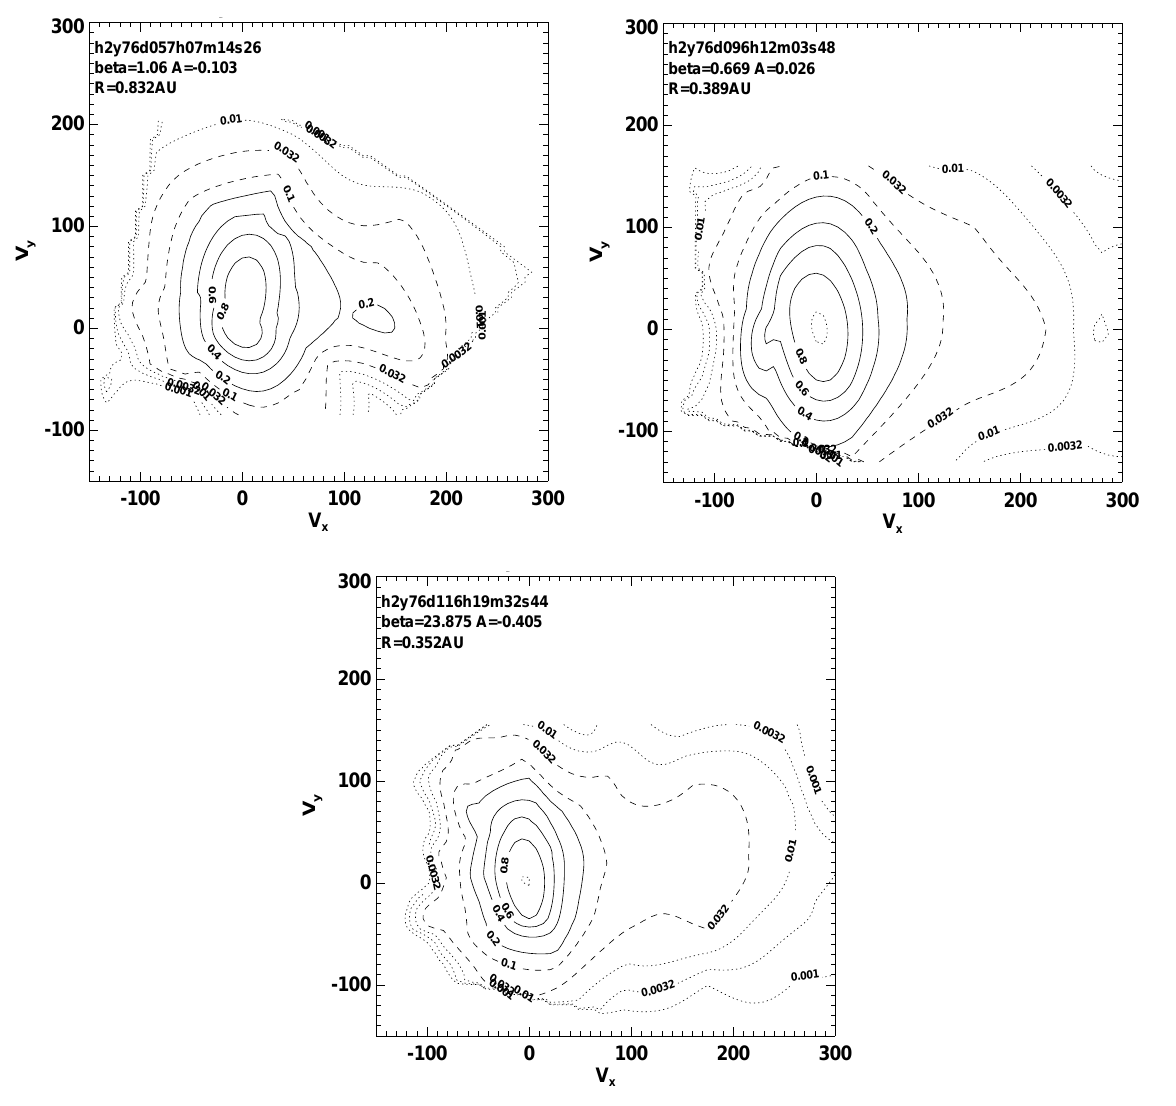
Fig. 1. Contours in velocity space of typical anisotropic proton velocity distribution functions. The contours correspond to 0.0032, 0.01 (outer dotted lines), 0.032, 0.1 (dashed), 0.2, 0.4, 0.6, 0.8 (continuous), and 0.9 (innermost dotted line) of the maximum. The v x -axis points in the magnetic field direction. The most prominent nonthermal features are the core temperature anisotropy, with T ⊥ c >T k c , and the proton beam travelling along the local magnetic field direction at speeds larger than the Alfv´en speed. Note that the artificially sharp edges in some contours correspond to the boundaries of the velocity array of the plasma instrument. From left to right, the parameter values are: plasma beta, β k = 1 . 06 , 0 . 67 , 23 . 9, anisotropy, A =− 0 . 1 , 0 . 03 , − 0 . 41, and heliocentric radial distance, R = 0 . 83 , 0 . 39 , 0 .